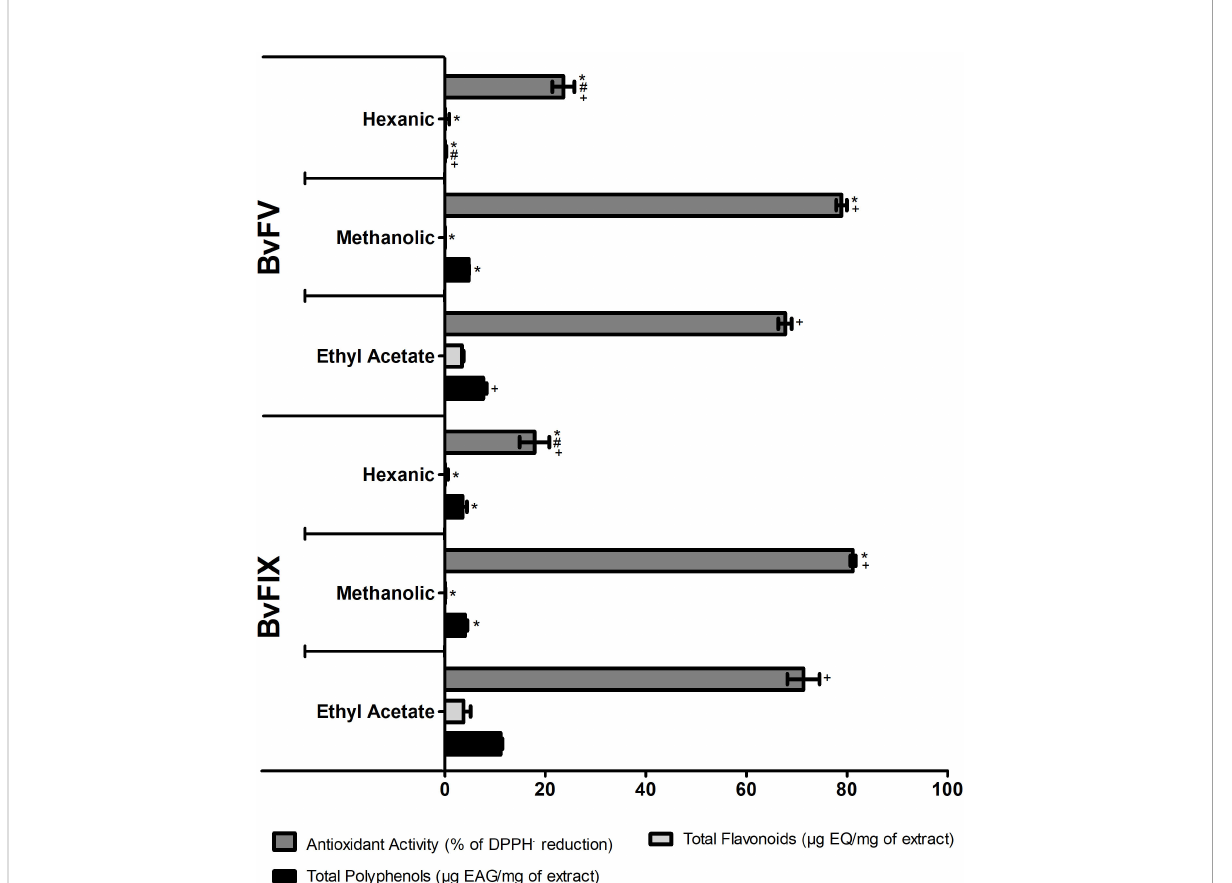
FIGURE 1 Total polyphenols and fl avonoids contents and antioxidant activity of the fractions of the crude extracts of the BvFV and BvFIX mycelia. The total polyphenolic contents of samples were expressed as gallic acid equivalents per mg of extract (EAG/mg). The total fl avonoid contents of samples were expressed as quercetin equivalent per mg of extract (EQ/mg). Antioxidant activity was a percentage of DPPH· reduction compared to the control. The results presented represent mean ± S.E.M. The statistical test applied was the analysis of variance (two-way ANOVA) followed by Bonferroni posttest. *, p < 0.05 vs. ethyl acetate fraction; #, p < 0.001 vs. methanolic fraction - comparisons among the different fractions of the same fungus. +, p < 0.001 - comparison between the fractions of the different